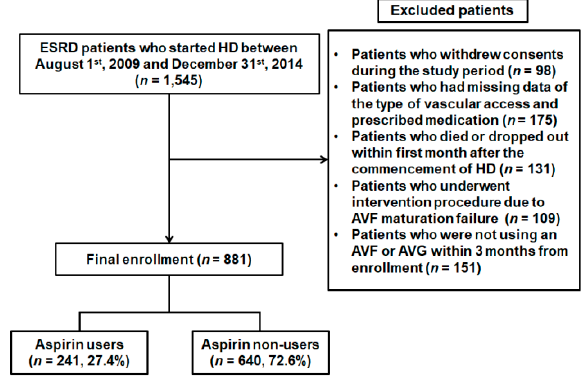
Figure 1. Flow diagram of the study subjects. From August 2009 to December 2014, 1545 patients who started HD at one of 36 centers of the CRC for ESRD in Korea were initially recruited for this prospective, observational multicenter study. According to the inclusion and exclusion criteria, 881 patients were included in the final analysis. Abbreviations; HD, hemodialysis; CRC for ESRD, clinical research center for end-stage renal disease; AVG, arteriovenous graft; DM, diabetes mellitus; AVF, arteriovenous fistula.